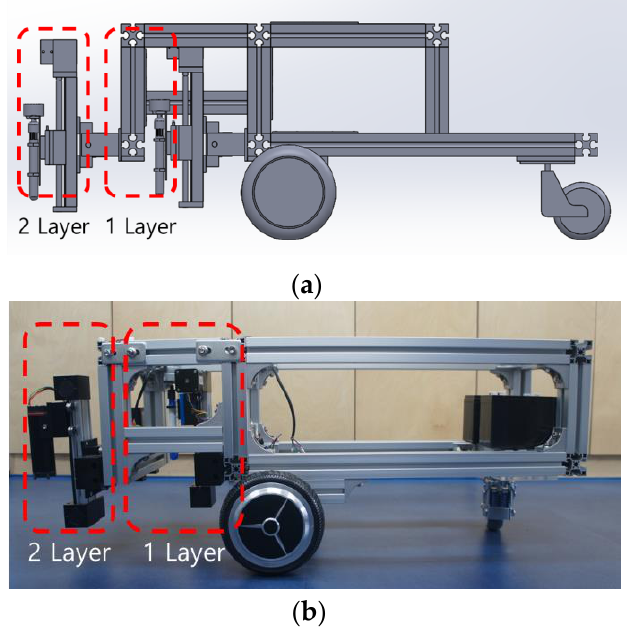
Figure 10. Profile of the multi-layer mechanical unit and mobile robot: ( a ) multi-layer mechanical unit design diagram and ( b ) multi-layer mobile robot.